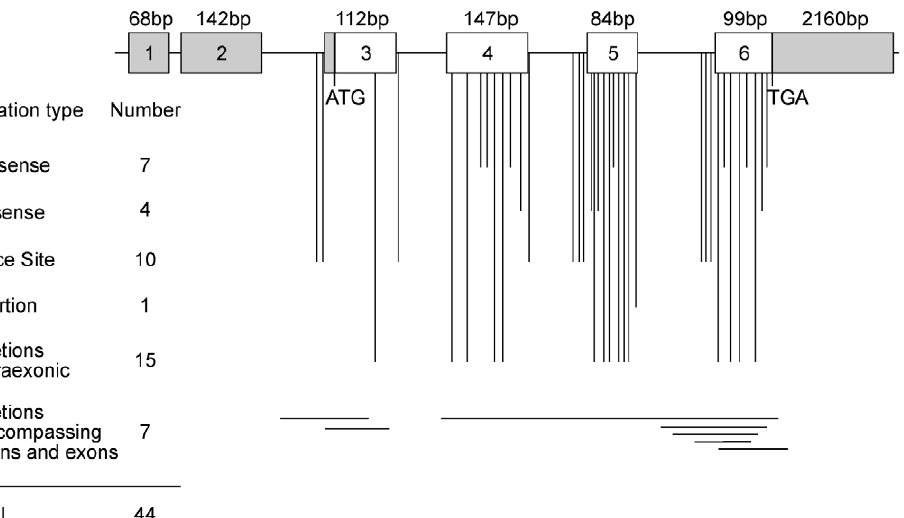
Figure 1. Schematic representation of genomic organization of the SEDL gene, illustrating the 44 identified mutations. The human SEDL gene consists of six exons that span approximately 22 Kb of genomic DNA and encode a 140 amino acid protein. The 420bp coding region (open boxes) is organised into 4 exons (exon 3 to exon 6) and 3 introns (indicated by a line, not to scale). Non-coding exons (filled boxes) consist of exons 1 and 2, the 5 9 portion of exon 3 and the 3 9 portion of exon 6. The sizes of the exons, and the translation Start (ATG) and Stop (TGA) codons in exon 3 and 6, respectively, are indicated. The locations of the 44 mutations are indicated, and these consist of: 7 nonsense, 4 missense, 10 splice site, 1 insertion, 15 intraexonic deletions, and 7 deletions that encompassed introns and exons. The four missense mutations (Asp47Tyr, Ser73Leu, Phe83Ser and Val130Asp) and one nonsense mutation (Gln131Stop) were selected for further functional studies (Figures 3, 4, 6 and 7).